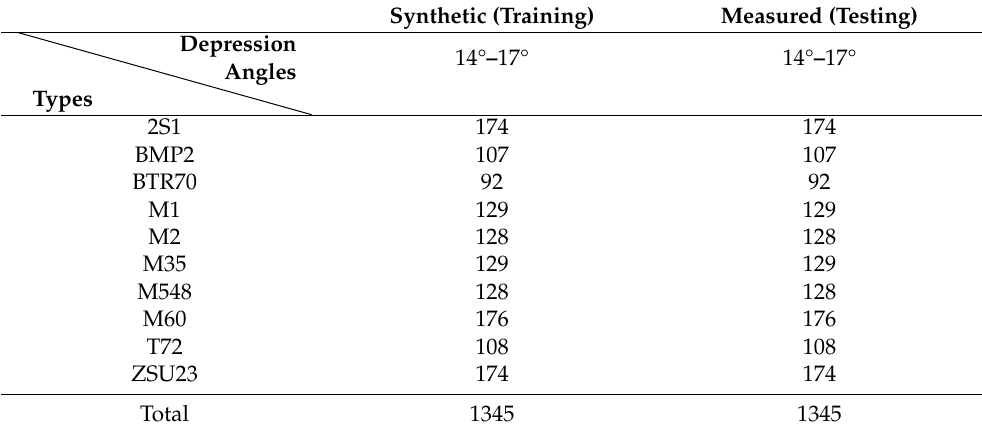
Table 1. Training Scenario I: data types and numbers of samples in original SAMPLE dataset.